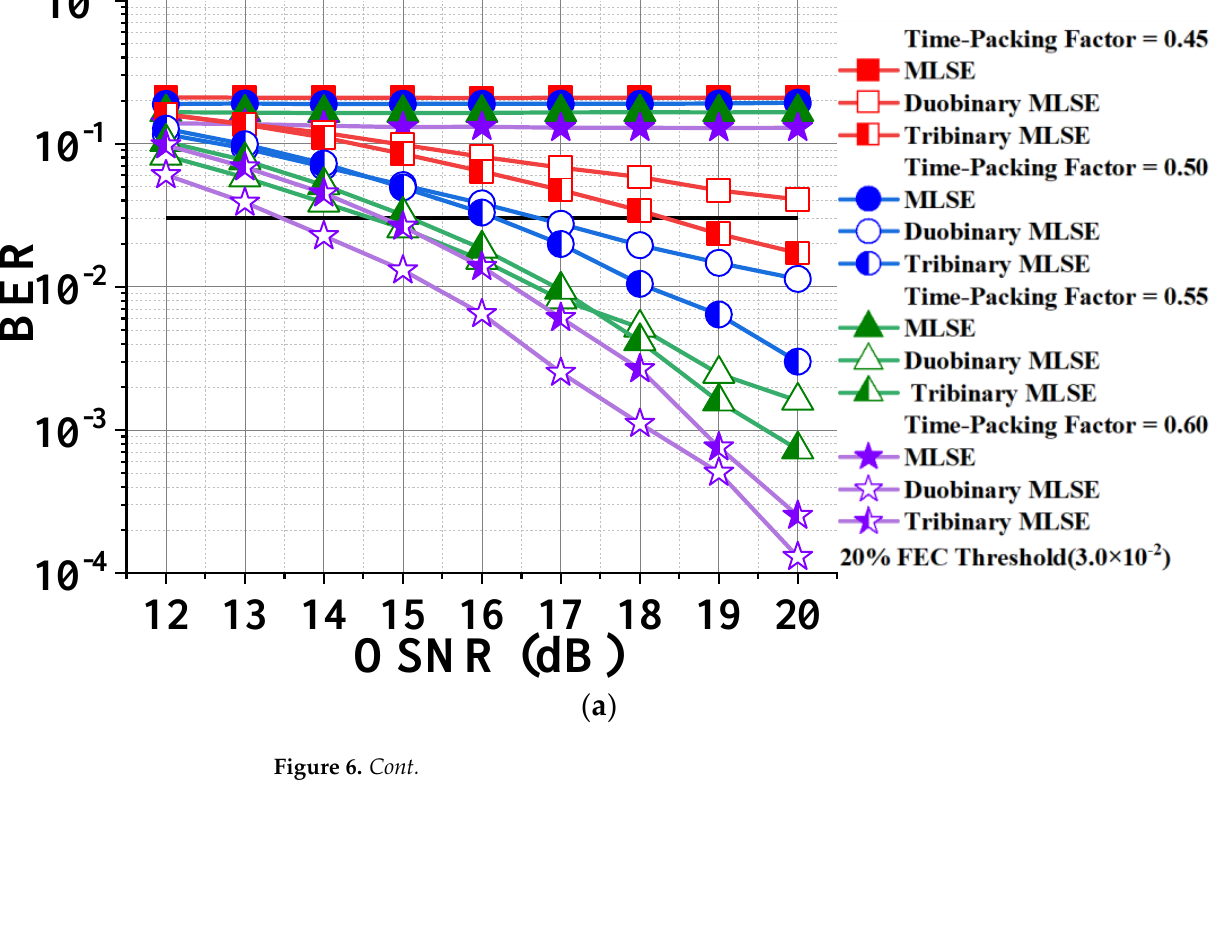
Figure 5. Simulation platform for 28GBaud PDM-FTN-QPSK system.